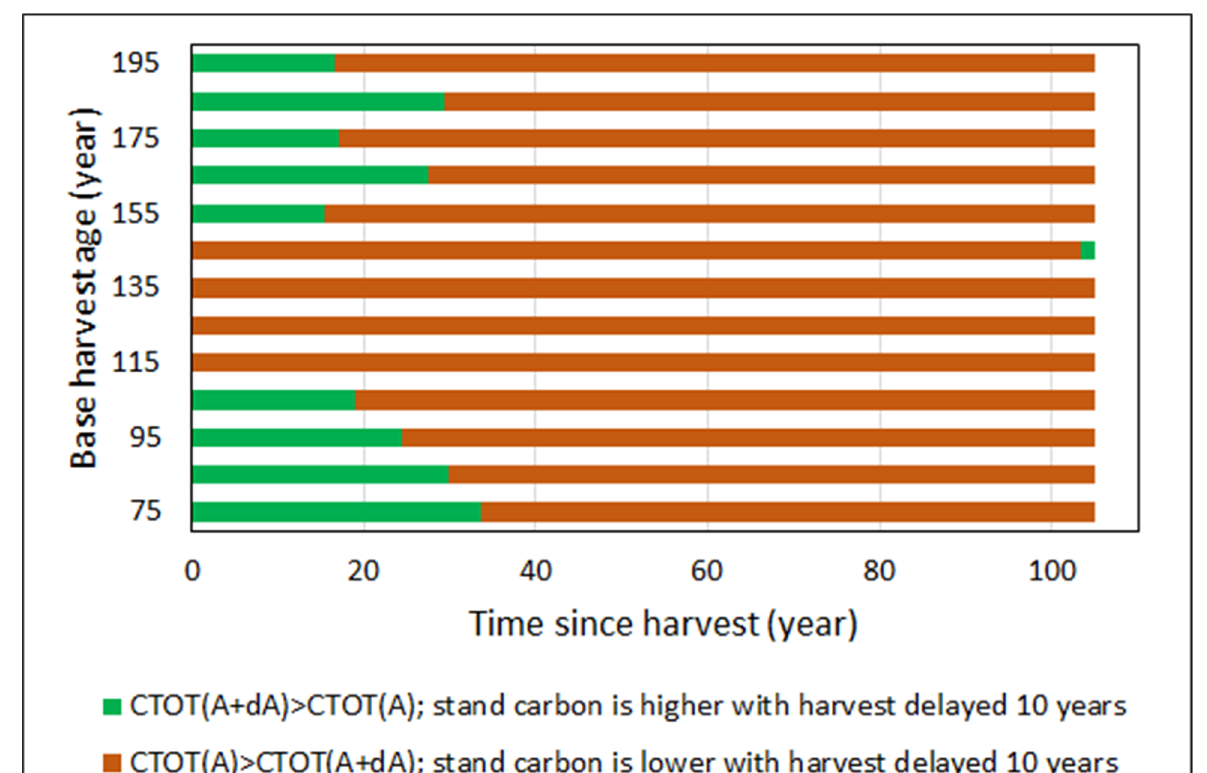
Figure 4. Climate change mitigation benefit profile of increasing base harvest age by 10 years for the jack pine-black spruce forest unit in the Pic River Forest management unit in northwestern Ontario.